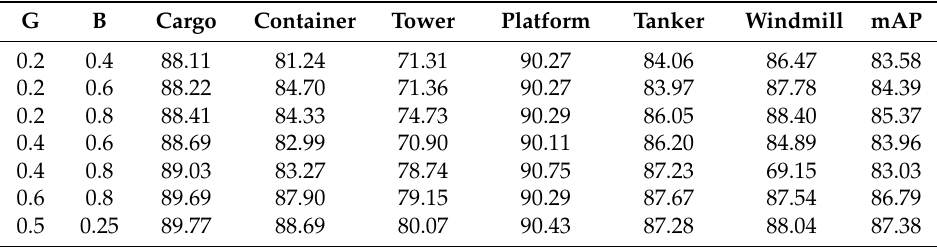
Table 14. Comparison of precisions (%) of MR-SSD with different low-pass filters. G B Cargo Container Tower Platform Tanker Windmill mAP